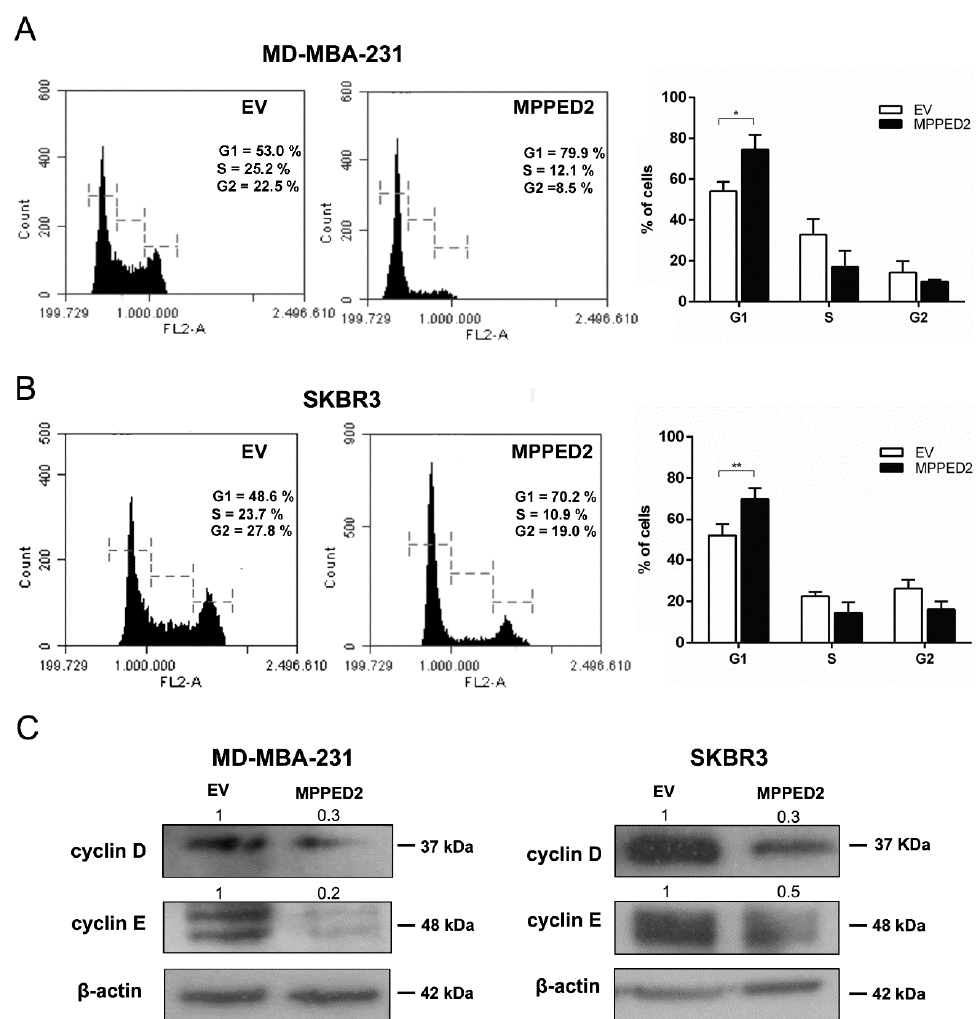
Figure 6. MPPED2 inhibits cell cycle progression of breast carcinoma cell lines. ( A , B ) Representative experiments of cell cycle analysis performed in MDA-MB-231 and SKBR3 cells stably transfected with MPPED2 or the corresponding empty vector (EV) are shown in left panel. Values shown in the right panel were obtained from three independent experiments. t -test: *, p = 0.0286 ( MPPED2 vs. EV, MDA-MB-231 G1 phase); **, p = 0.0079 ( MPPED2 vs. EV, SKBR3 G1 phase). ( C ) Western blot analysis of cyclin D and cyclin E expression in MD-MBA-231 (left panel) and SKBR3 (right panel) stably expressing MPPED2 or carrying the corresponding empty vector (EV). β -actin was used to normalize the amount of loaded protein. Densitometric analysis was performed by using ImageJ software to analyse protein expression compared to the EV, set equal to 1. Original blots were shown in Supplementary Materials Figure